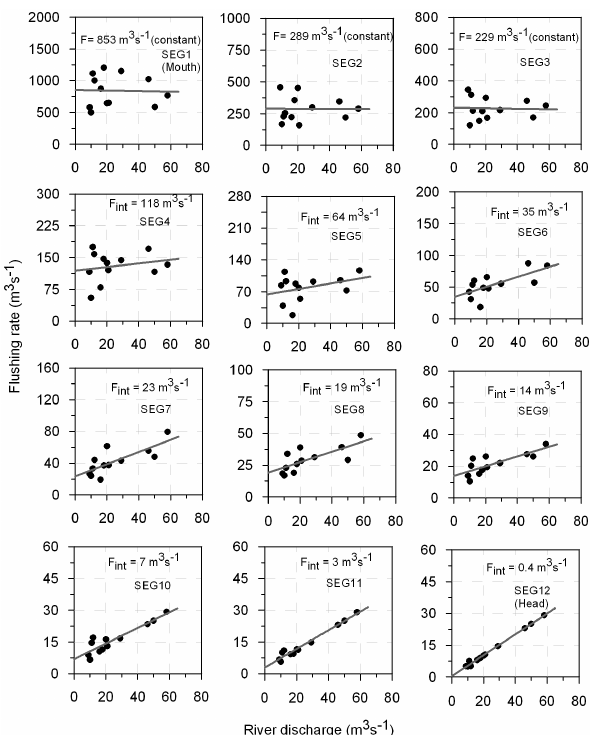
Fig. 9. Plot of the flushing rate ( F ) against the river discharge ( R ) for various segments of the Sumjin River Estuary during spring tide. The intercept value, F int , indicates the tidal exchanges. The amounts in excess of the F int value for various river discharges in- dicate gravitational circulation exchange (here expressed by G c ). Gravitational circulation exchanges entirely dominate at the up- stream end.